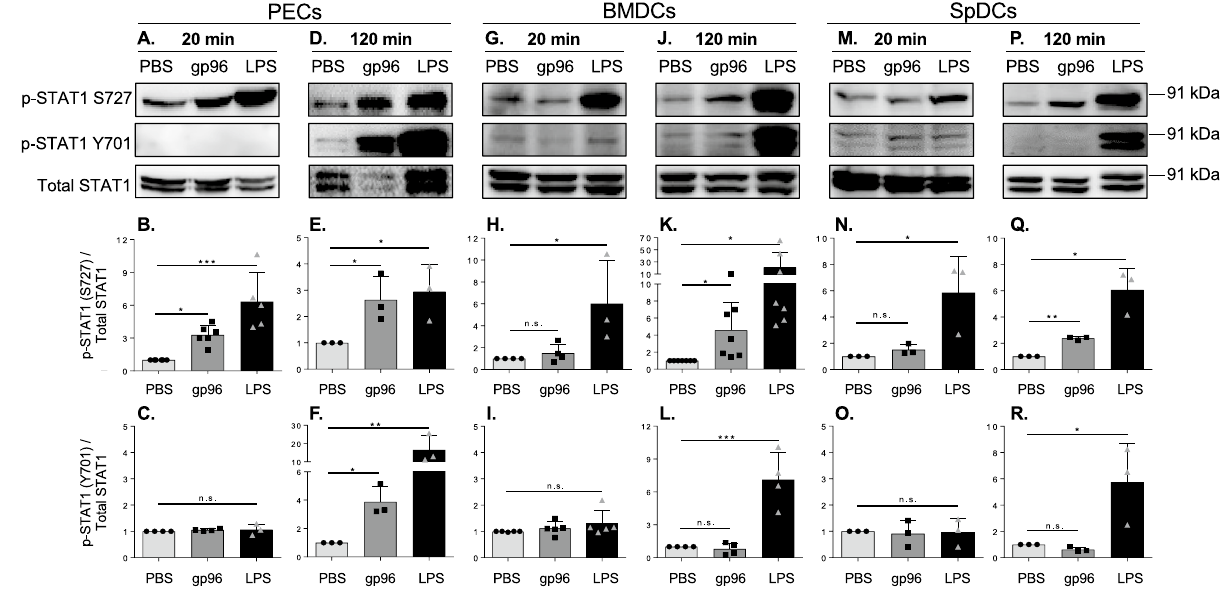
Figure 3. Differential STAT1 phosphorylation in PECs and DCs in response to gp96. (A–F) PECs, (G–L) BMDCs, or (M–R) SpDCs were activated with 200 µ g/mL gp96 for (A–C, G–I, M–O) 20 or (D–F, J–L,